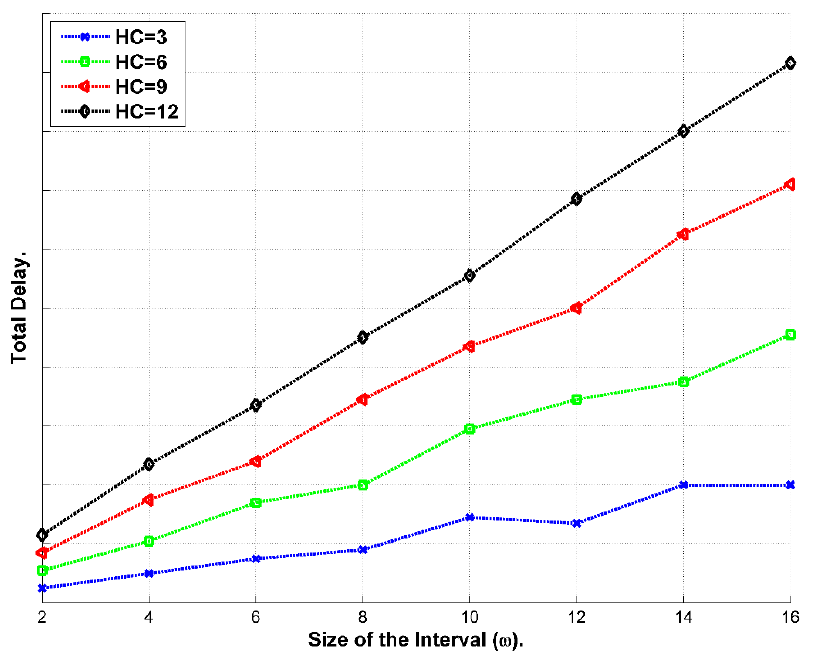
Figure 23. The accumulated delay is a function of the hop count (hc) and the size of 